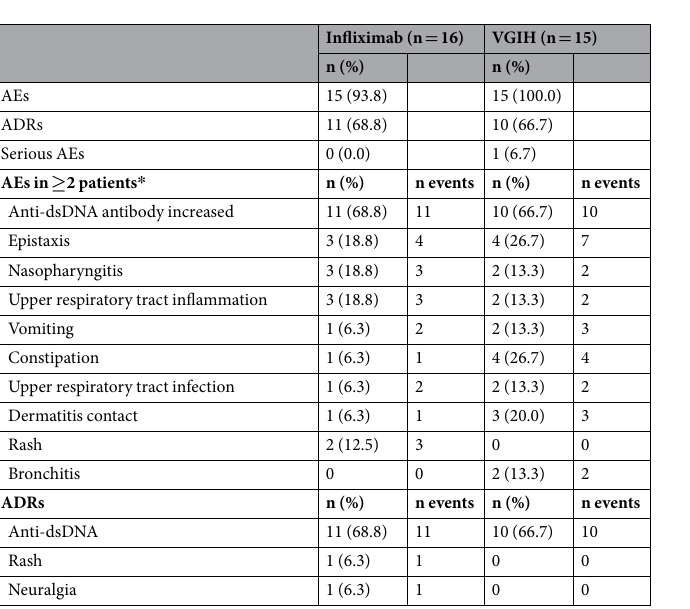
Table 2. Safety profiles. * AEs in one patient each in the infliximab group: arthropod sting, contusion, diarrhea, disuse syndrome, dry skin, ear pain, liver function test abnormal, miliaria, neck pain, neuralgia, pyrexia, increased transaminases, urticaria. AEs in one patient each in the VGIH group: activated partial thromboplastin time prolonged, anal hemorrhage, blood cholesterol increase, conjunctivitis, decubitus ulcer, drug eruption, peripheral edema, eosinophil count increase, fungal skin infection, KD, pharyngitis, renal tubular disorder, respiratory depression, skin erosion, skin injury, stomatitis, and urine positive for white blood cells. ADR, adverse drug reaction; AE, adverse event; anti-dsDNA, anti–double-stranded DNA; KD, Kawasaki disease; VGIH, polyethylene glycol-treated human